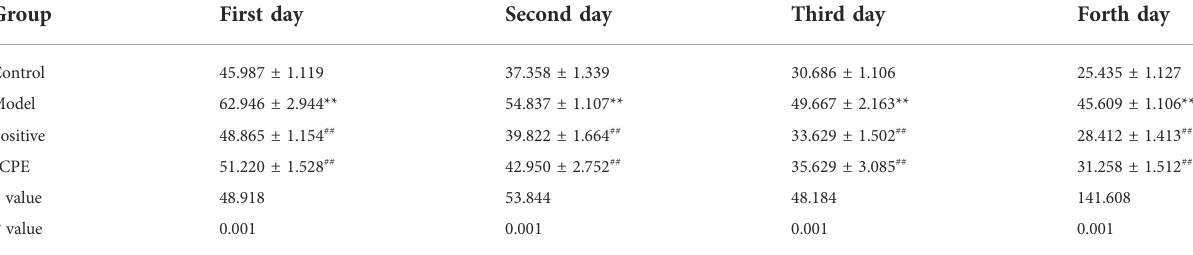
TABLE 1 Effect of SCPE on the escape latency of D-galactose model mice (mean ± SD, n = 15). Group First day Second day Third day Forth